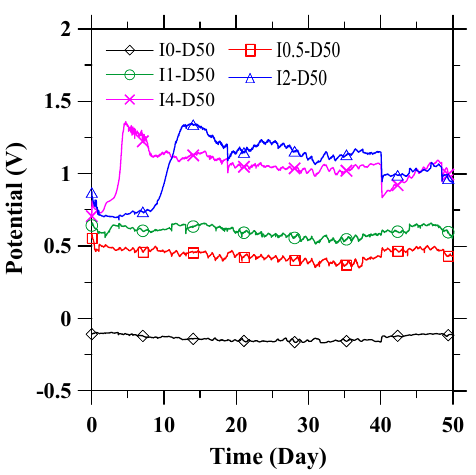
Figure 4. The potential ( vs. SCE) of CFRP during galvanostatic anodic polarization process.